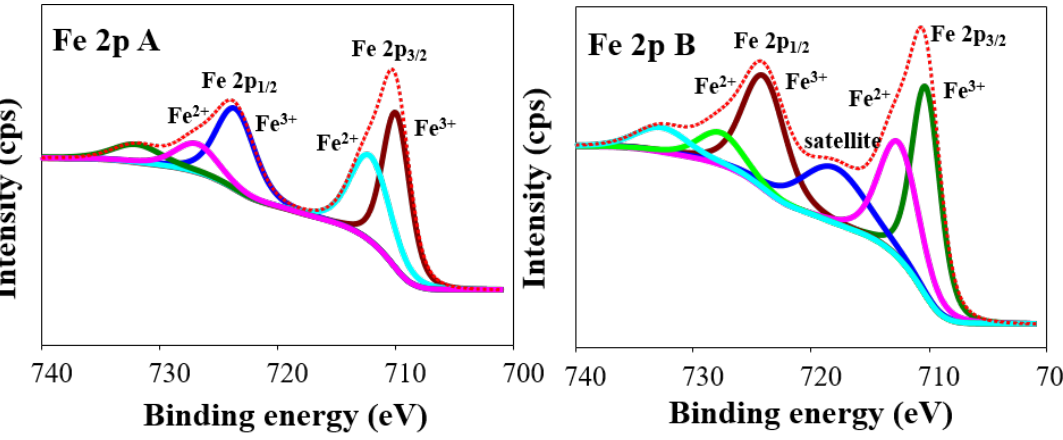
Figure 4. The high-resolution XPS spectrum of the Fe 2p peaks of ( A ) HNTs-Fe 3 O 4 -CTs, and ( B ) HNTs-Fe 3 O 4 -CTs-S-S-Laccase.